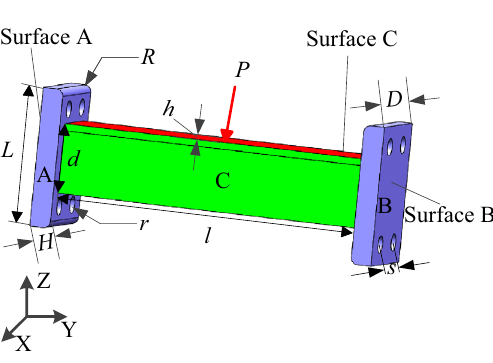
Figure 22. Support-connecting rod-support